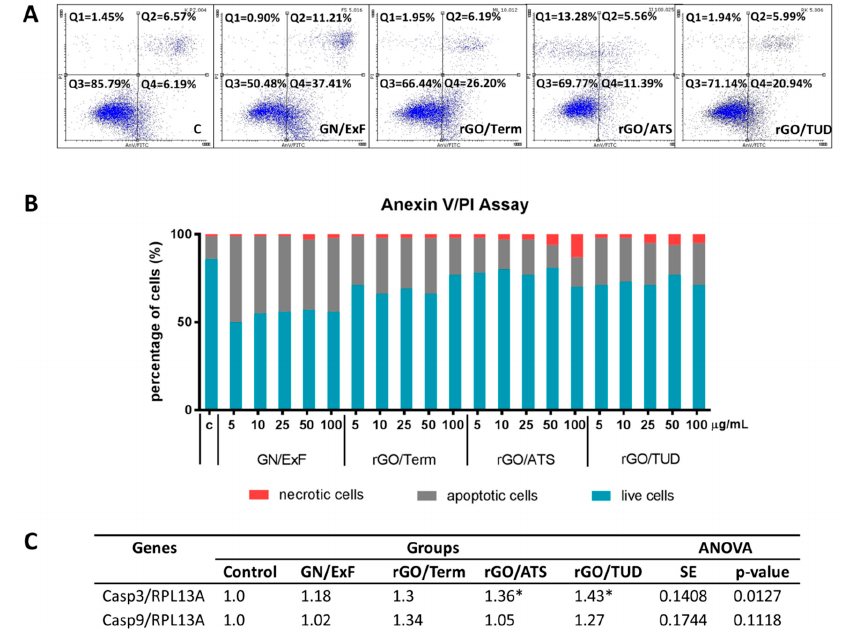
Figure 5. Determining the type of death of U87 cells untreated and treated with GN and rGO flakes via Annexin V-FITC and PI assay, and via the evaluation of casp3 and casp9 gene expression. ( A ) Cells were stained with Annexin V/PI and analyzed by flow cytometry. Scatter diagrams show cells untreated and treated with graphene flakes and reduced graphene oxide flakes at the following concentrations: GN/ExF (5 μ g/mL), rGO/ATS (100 μ g/mL), rGO/Term (10 μ g/mL), and rGO/TUD (5 μ g/mL, treated for 24 h. Quadrants in the cytograms show live cells (Q3) and individual stages of cell death: Q1—necrotic cells, Q2—late apoptotic cells, and Q4—early apoptotic cells. ( B ) Chart shows the percentage of apoptotic and necrotic cells for all the tested concentrations (5, 10, 25, 50, and 100 µ g/mL) of GN and rGOs. ( C ) Gene expression profile in glioblastoma cell line U87; gene expression of casp3 and casp9 in U87 cells untreated and treated with graphene (GN) or reduced graphene oxide (rGO) flakes. Bonferroni’s multiple comparison test was used for statistical analysis. Values in rows marked with an asterisk show significant differences. Values marked with one asterisk (*) indicate a p -value < 0.005. Values were normalized to that of the reference gene house-keeping gene rpl13a . The expression level of the examined genes was expressed as the relative quantitation (RQ) value. Abbreviations : PI, propidium iodide; FACS, fluorescence assisted cell sorting; Q, quadrant; C, control group (untreated cells); rGO, reduced graphene oxide; GN,